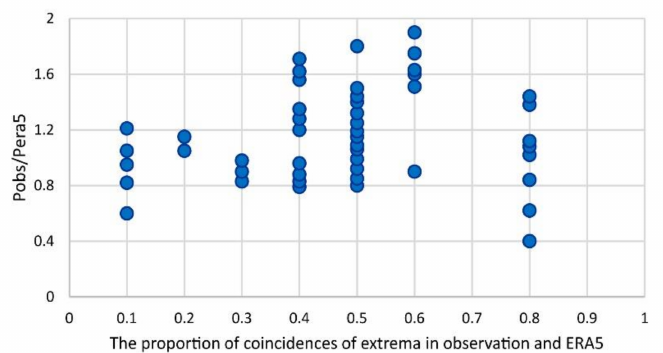
Figure 4. The proportion of coincidences in the 10 observed (at all stations—see the Figure 1) largest precipitation extremes with similar extrema according to ERA5 data at these grid points (abscissa axis) and the ratio of observed precipitation (Pobs) to the total of ERA5 data (Pera5) (ordinate